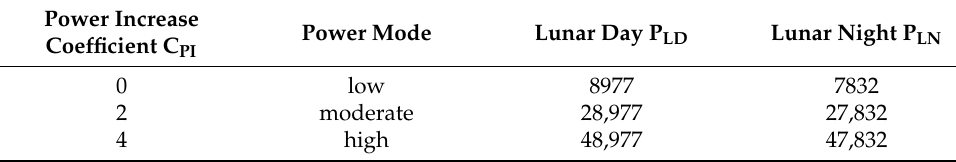
Table 16. The lunar base power loads at various power modes.